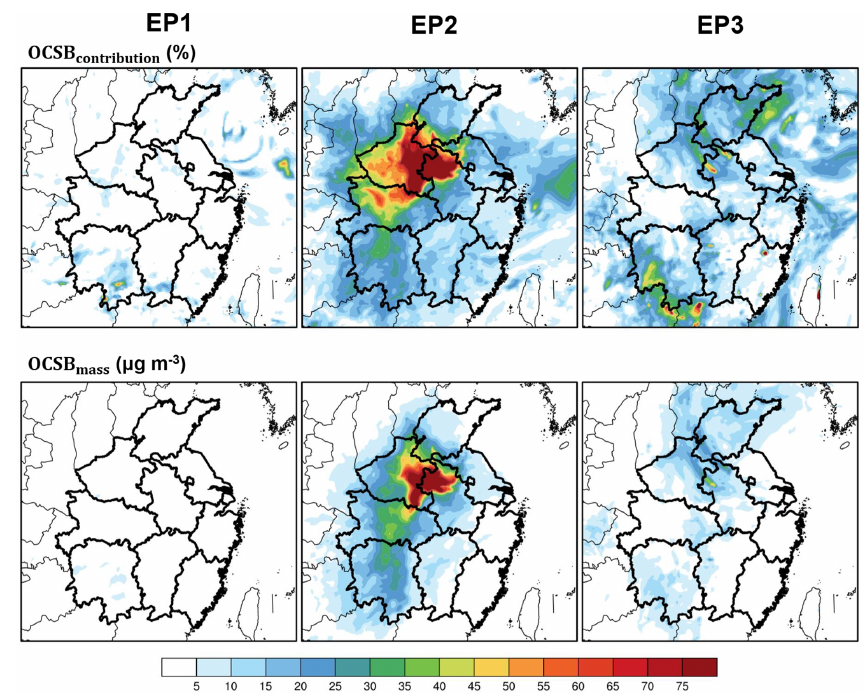
Figure 10. The same as Fig. 9 but for OCSB mass and OCSB contribution . The maps were created by NCAR Command Language (NCL) (http://www.ncl.ucar.edu/, last access: 19 December 2019).